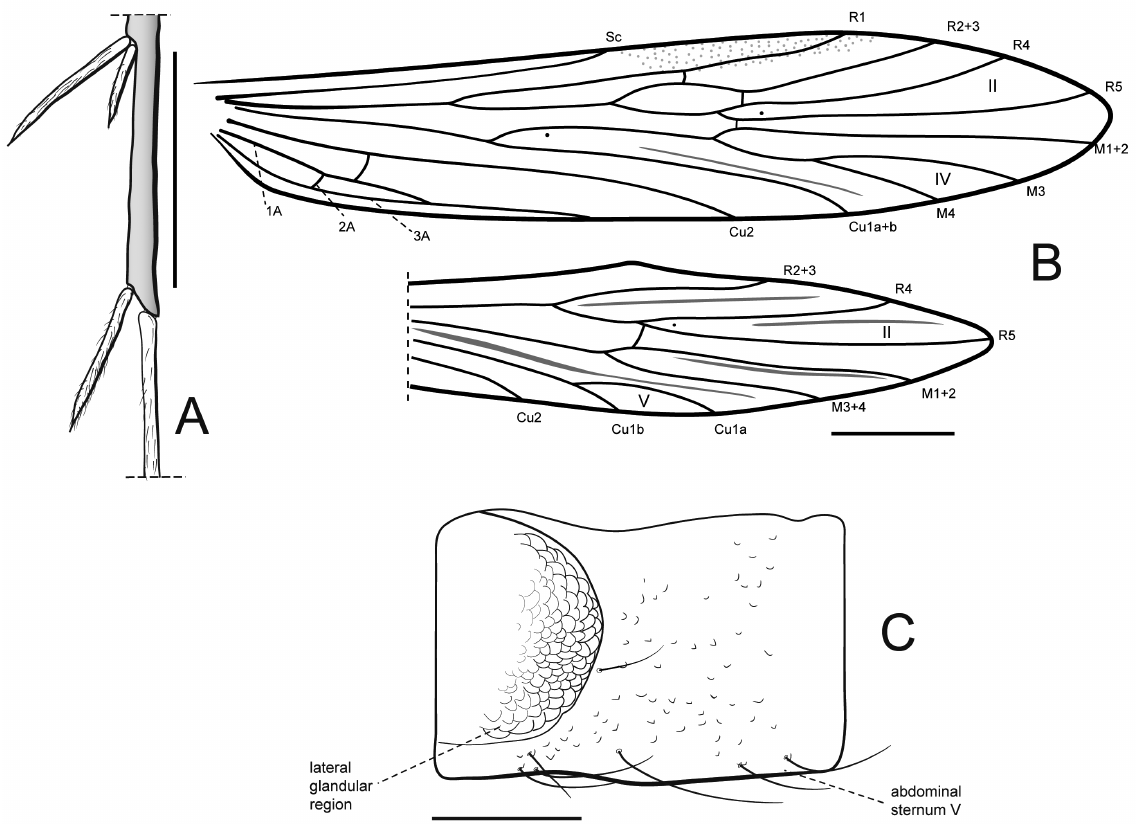
Fig. 2. Xiphocentron ( Antillotrichia ) copacabana sp. nov., holotype, adult, ♂. A . Tibial spurs of the hind leg. B . Right wings, dorsal view. C . Glandular region of abdominal sternum V , left lateral. Scale bars: A–B = 0.5 mm; C = 0.1